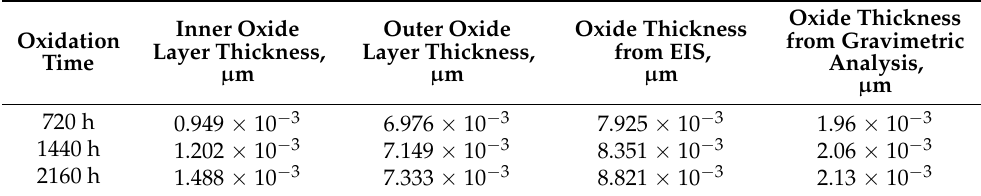
Table 6. Layer thickness values obtained using the plane capacitor formula for samples oxidized for different periods of time in water at 550 ◦ C and 250 atm.